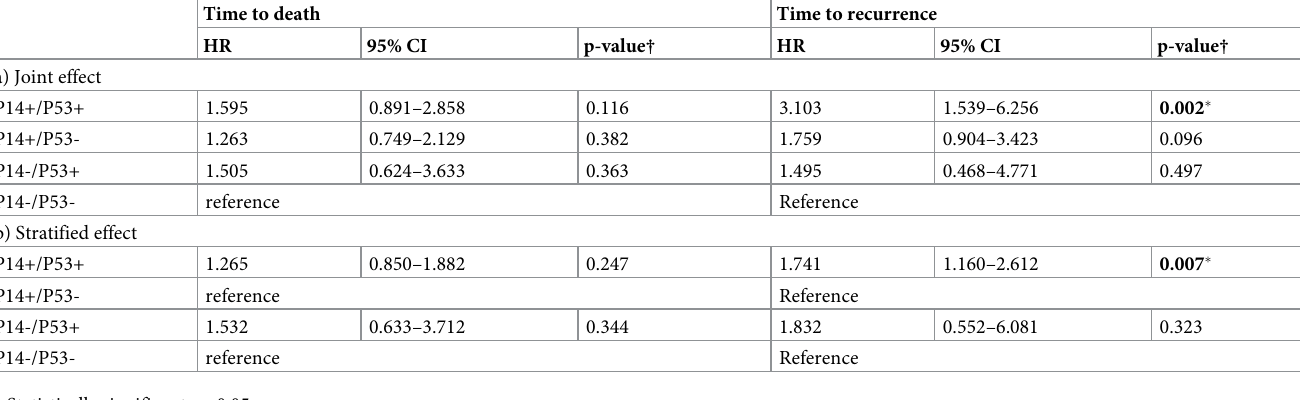
Table 4. Association of p14 and P53 status with overall and disease-free